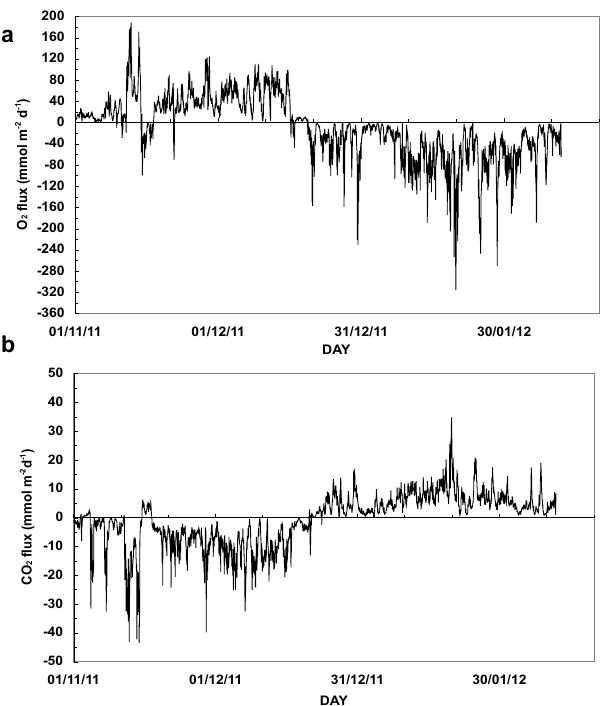
Figure 6. Air–sea flux from 1 November 2011 to 12 February 2012 in mmolm − 2 d − 1 (positive for outgassing). (a) O 2 ) , (b) CO 2 .